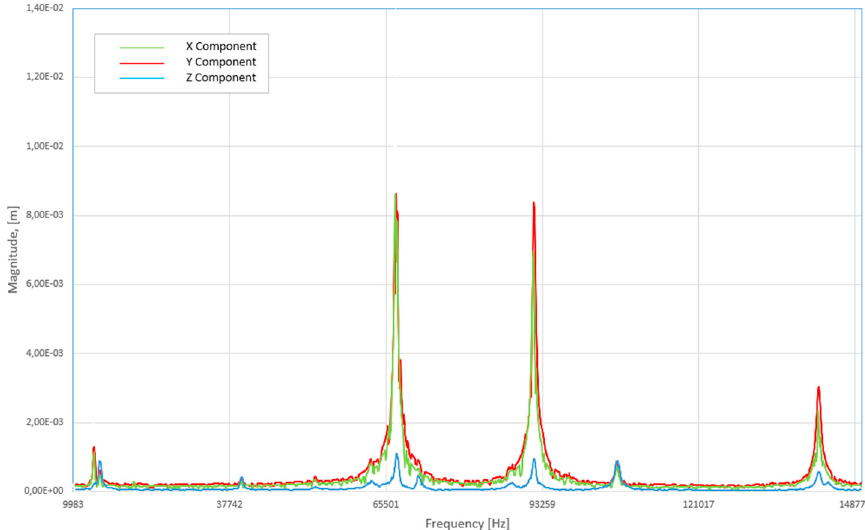
Figure 11. Versus frequency graph with the peak oscillation values at 65 and 91.6 kHz: red—X coordinate, green—Y coordinate, blue—Z coordinate.